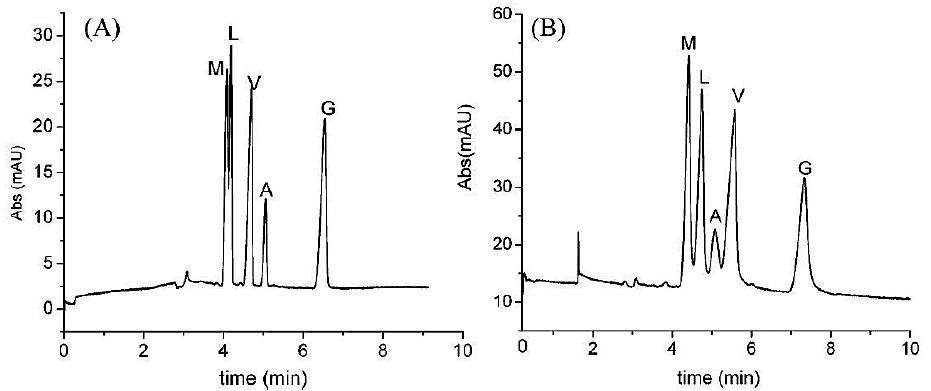
Figure 10. Effect of SWCNTs coated monolithic column on the separation of a peptide mixture “Reproduced with permission from Y. Li et al. [49] Copyright American Chemical Society, 2005”. ( A ) Polymer monolithic column containing SWCNTs; ( B ) Polymer monolithic column in the absence of SWCNTs, Val-Tyr-Val (V), leucine enkephalin (L); ( A ) angiotensin II, methionine enkephalin (M), Gly-Tyr (G).